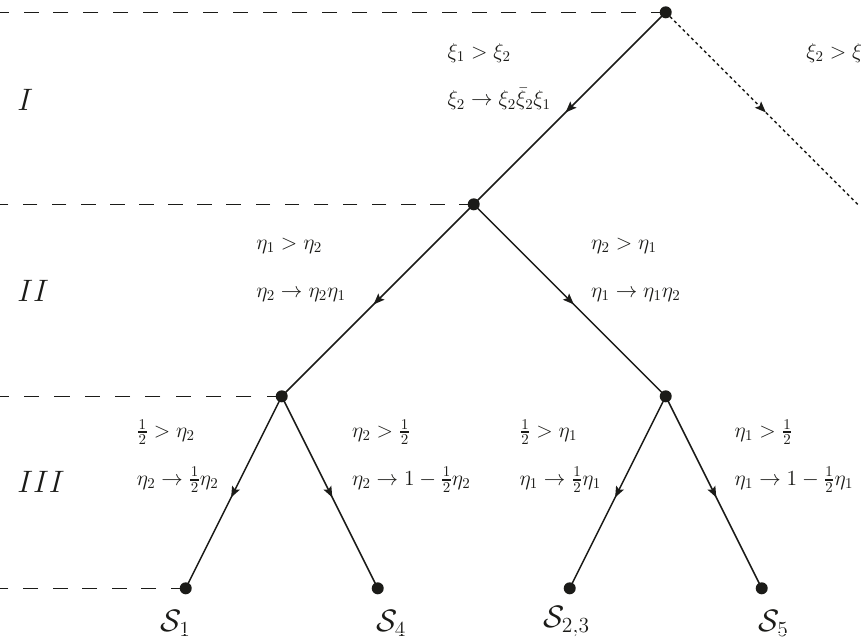
Figure 1 . Decomposition tree of the triple-collinear sector unresolved phase space. The omitted right branch of the tree corresponds to a di(cid:11)erent ordering of the energies of the unresolved partons, and can be obtained by renaming the indices of the variables, 1 implicitly in eq.